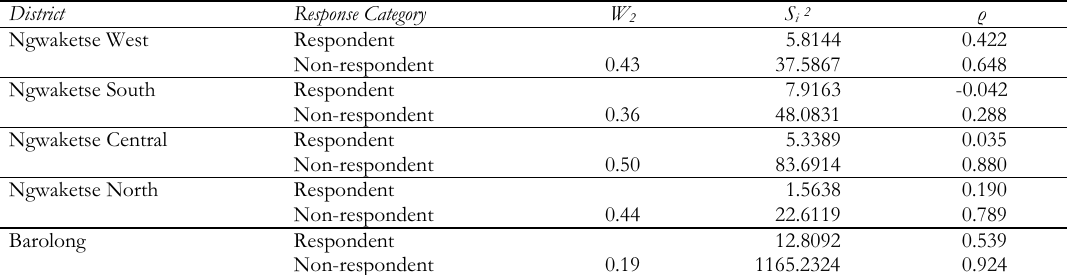
Population parameters (non-respondents) for 1999/2000